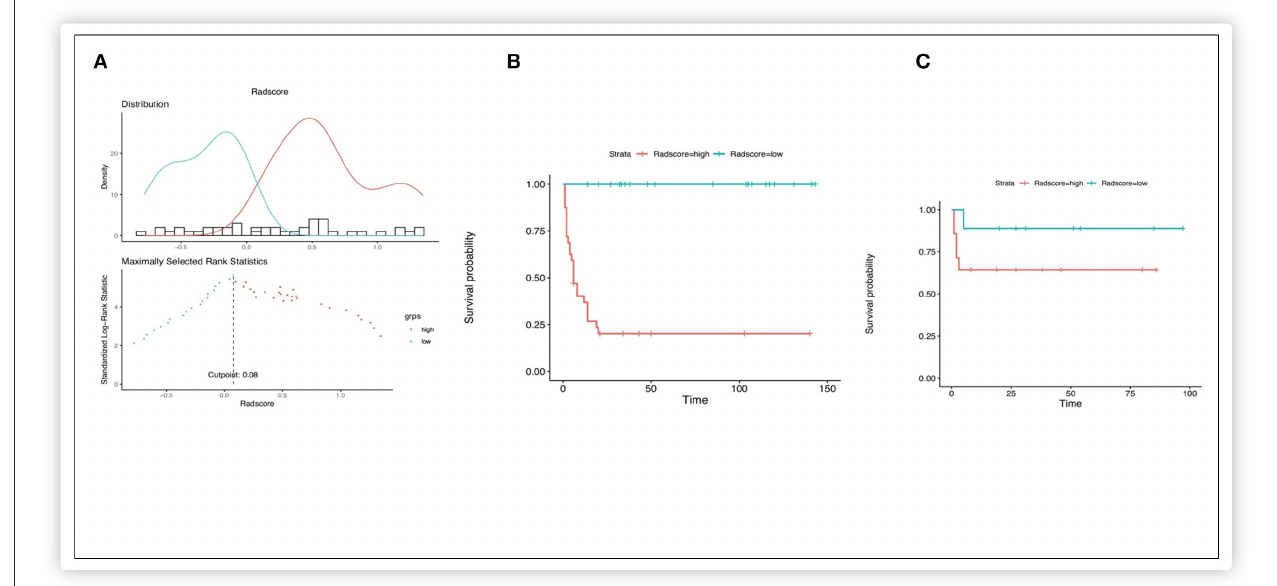
FIGURE 2 | Kaplan-Meier survival analysis of event-free survival of patients with HB. Graphs show results of Kaplan-Meier survival analyses according to the radiomics score cutoff value (A) for patients in the training data set (B) and those in the validation data set (C) . A significant association of the radiomics score with the EFS was shown in the training data set, which was then confirmed in the validation data set.